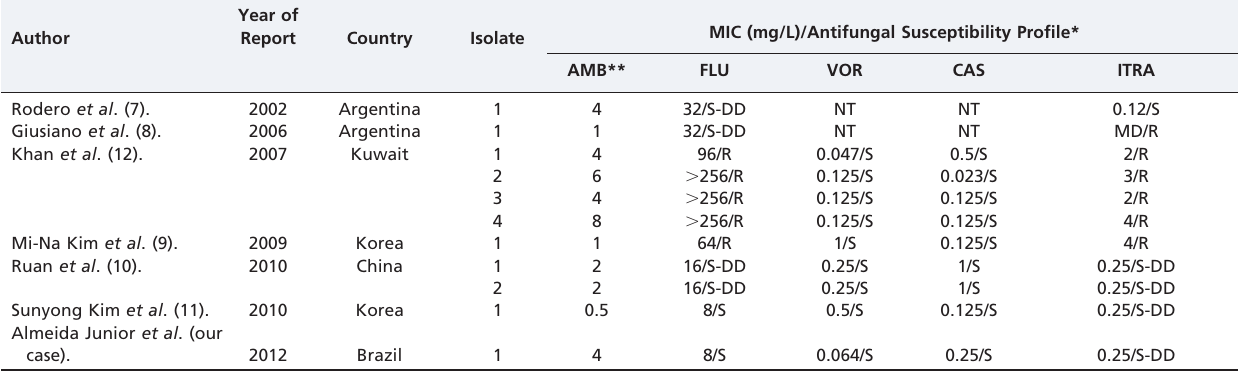
Table 3 - Comparison of the antifungal susceptibility of Candida haemulonii bloodstream isolates according to author and the year of publication.